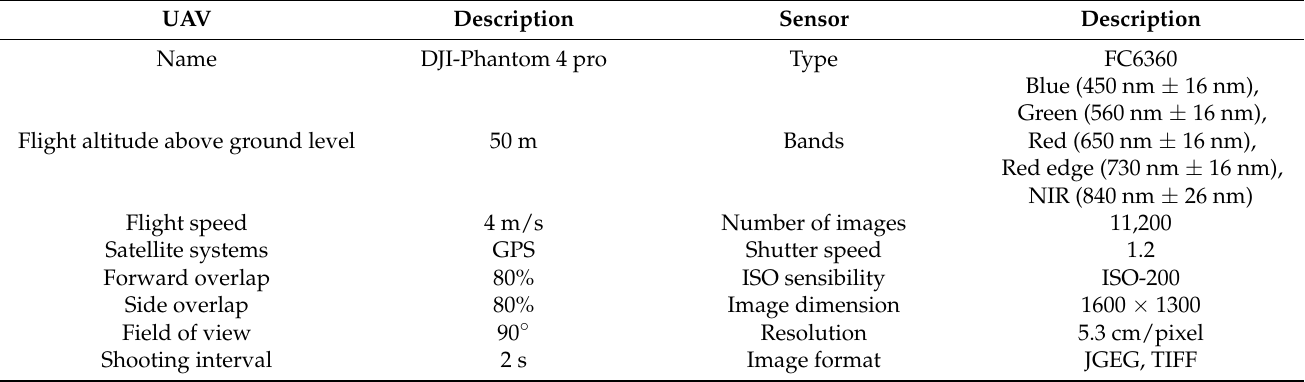
Table 1. Basic information on UAV remote sensing observation